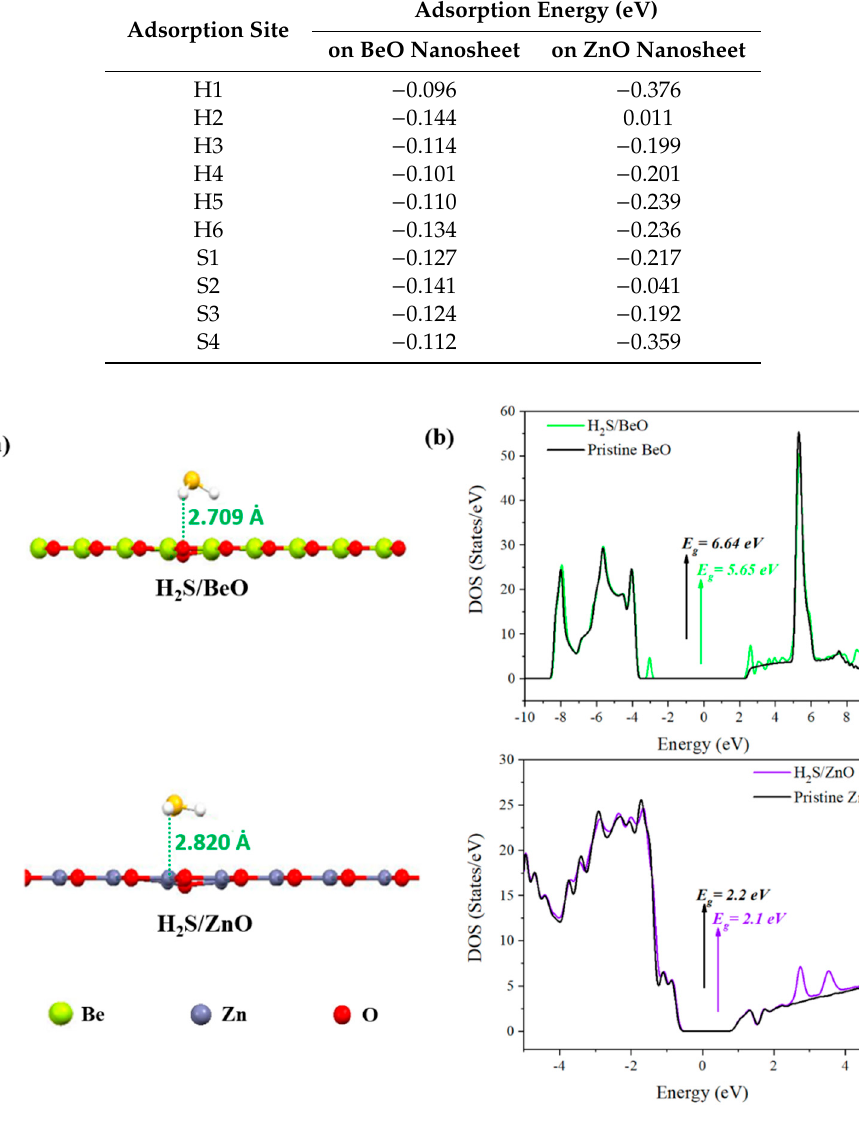
Figure 3. ( a ) Side views of the optimized structures and geometrical parameters of the adsorption of the H 2 S molecule on the surface of BeO and ZnO nanosheets at sites H2 and H1, respectively; ( b ) DOS calculated for BeO and ZnO nanosheets before and after adsorption of the H 2 S molecule at sites H2 and H1, respectively (the Fermi level is set to zero).